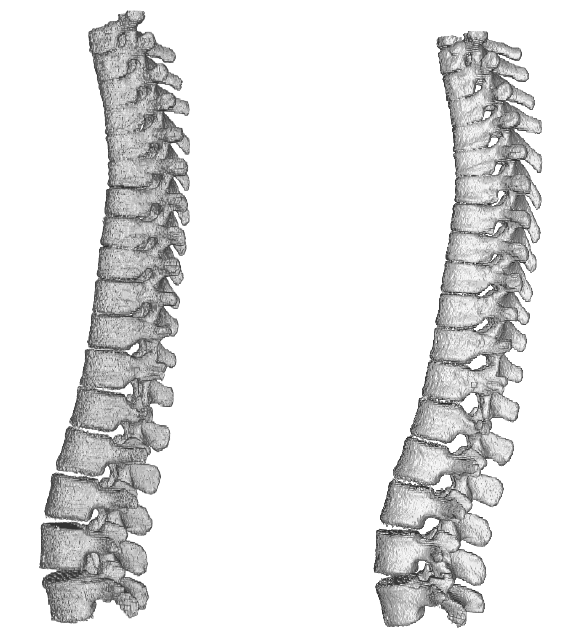
Figure 10. Comparison of ground truth model ( left ) and model segmented by Dense-U-Net network ( right ) after the fine-tuning phase of training. Notice difference on top of the figure—the first cervical vertebra and abnormal vertebrae adhesions that exist also in the original ground truth mask. Table 7. Segmentation results using Dense-U-Net and spine dataset in the fine-tuning phase. Results includes standard deviation of 3-folds cross-validation. Used metrics are: pixel accuracy, Dice coefficient, intersection over union, average Hausdorff distance [voxel] and area under ROC